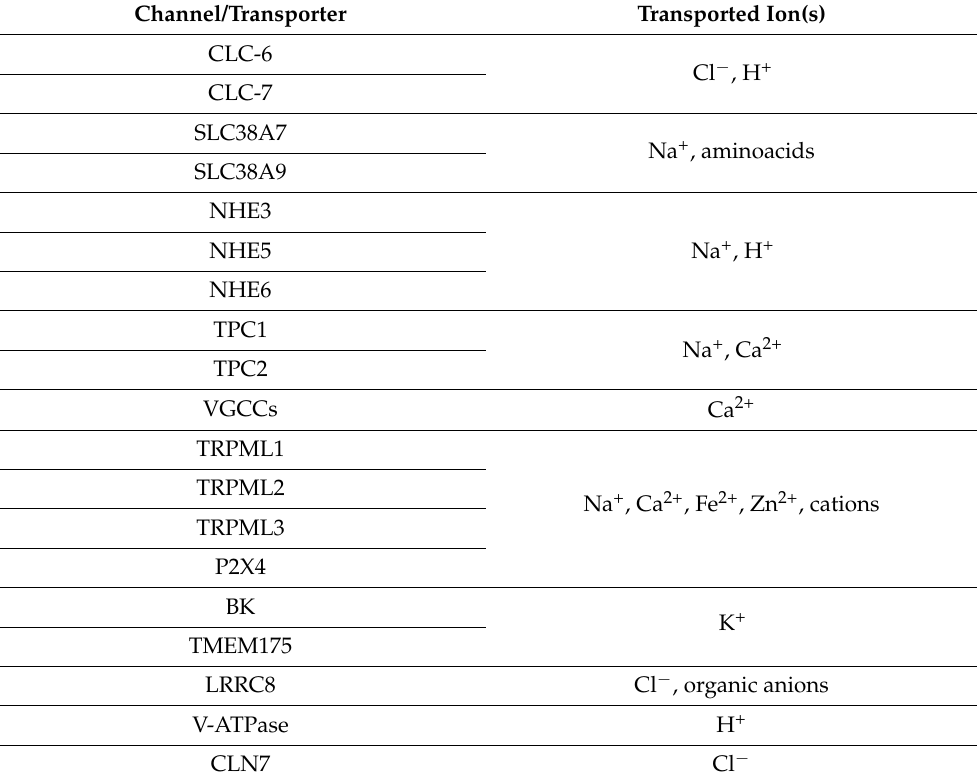
Table 1. Lysosomal channels and transporters (related references inserted in the main